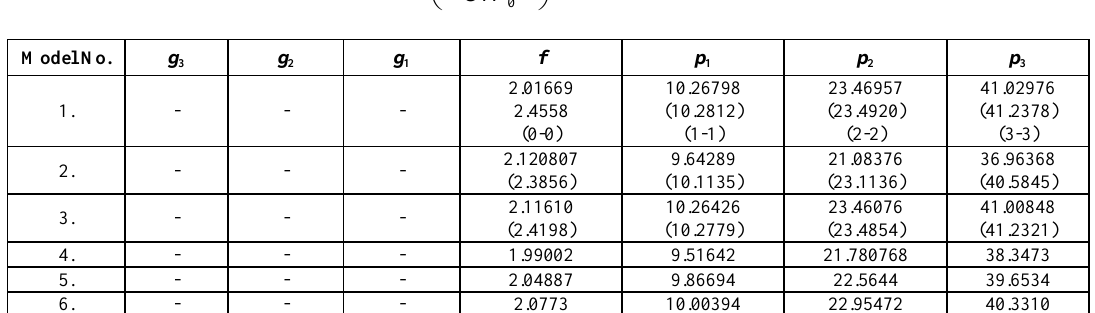
Table 3. Eigen frequencies of polytropic models of stars with index 1.5.